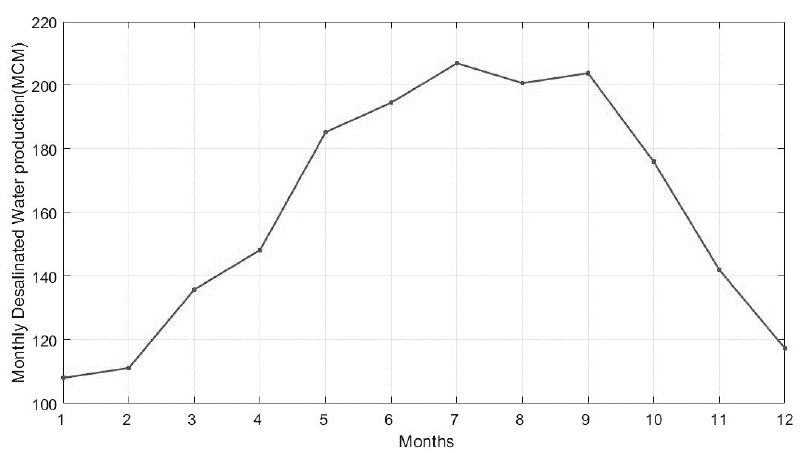
Figure 5. Monthly desalinated water production for the year 2008.